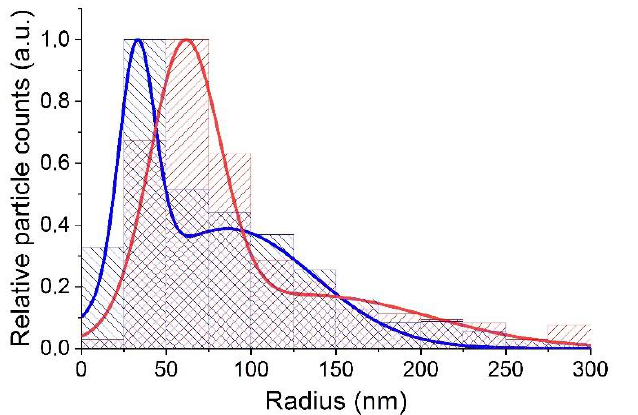
Figure 6. The size distributions of the 0.1 at. % Nd 3+ : LaF 3 nanoparticles in deionized water as measured for samples taken from the upper (blue) and lower (red) parts of the cell.